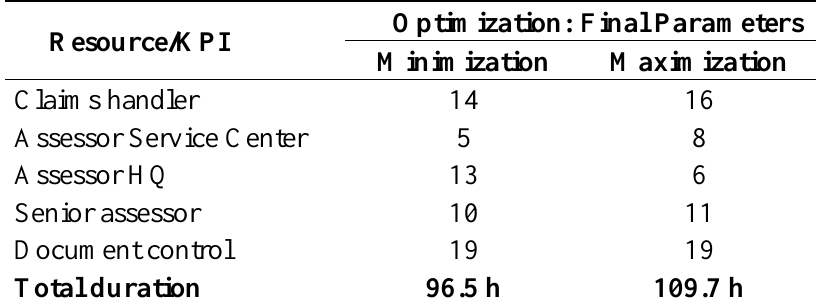
Table 16. Interval-valued